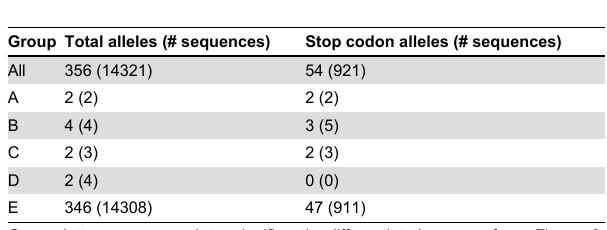
Table 4. Changes on the amino acid level for PLS .